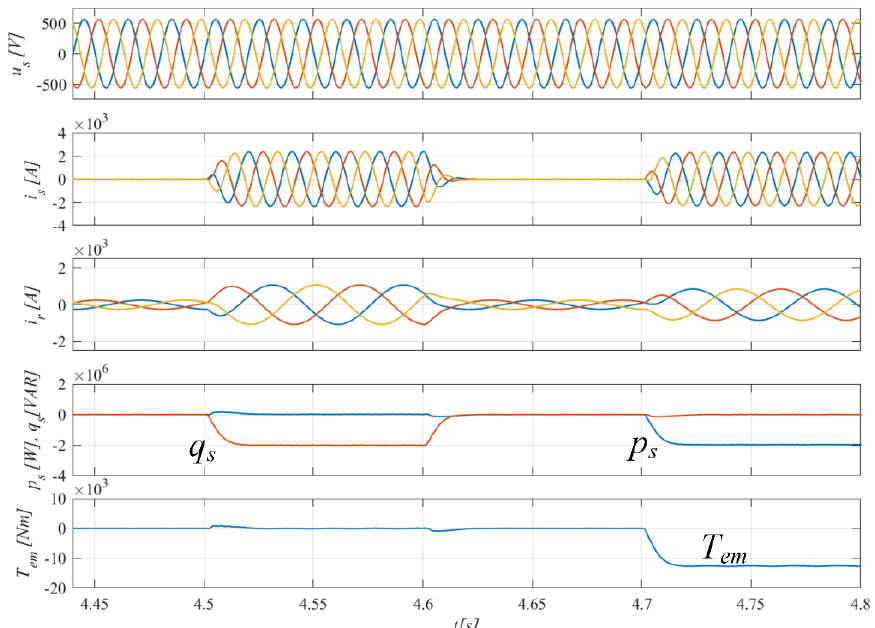
Figure 9. Simulation results of DPC in case of symmetrical grid voltage with the feedforward and decoupling mechanism. The stator current signal contains information about the rotor value.